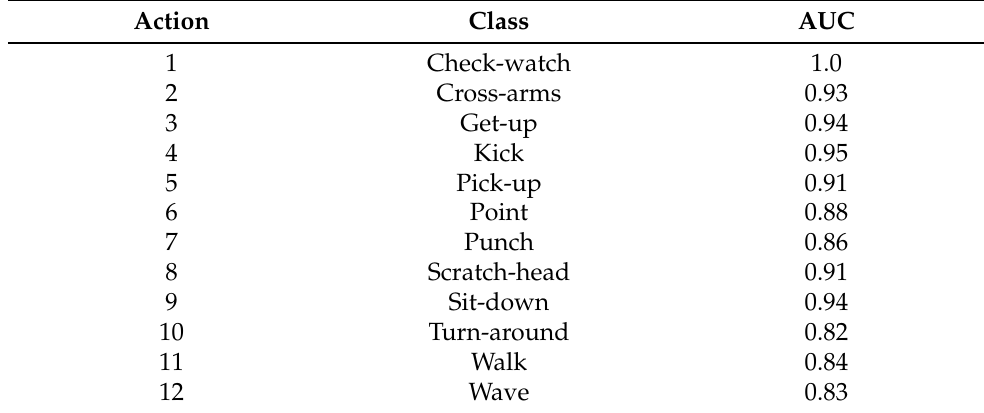
Table 7. The area under the curve as per class on IXMAS dataset with EFS technique.